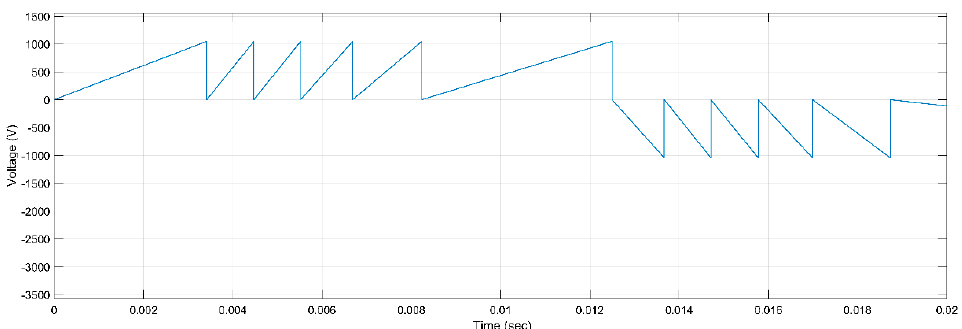
Figure 25. PD Activity for ER, 5 kV, 2 h, r.